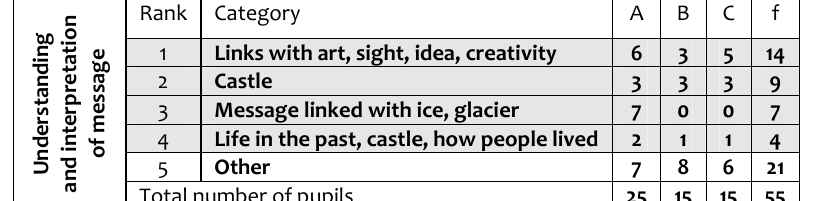
Table 16: Ranking order of categories of answers regarding understanding and interpretation of the message of the sixth example (Christo & Janne Cloude, Wrapped Reichstag, Berlin, 1971 –